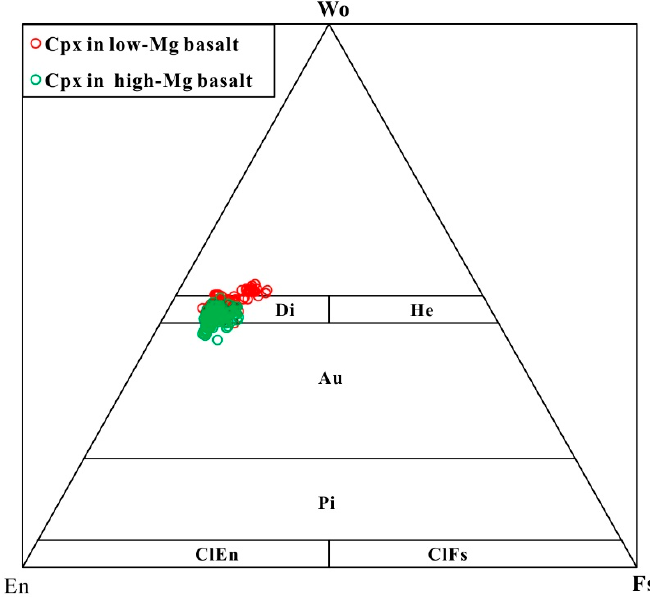
Figure 5. The pyroxene composition diagram (Di—diopside, Hehedenbergite, Au—Augite, Pi—Pigeonite, ClEn—clinoenstatite, ClFs—clinoferrosilite, Morimoto, 1988 [69]).